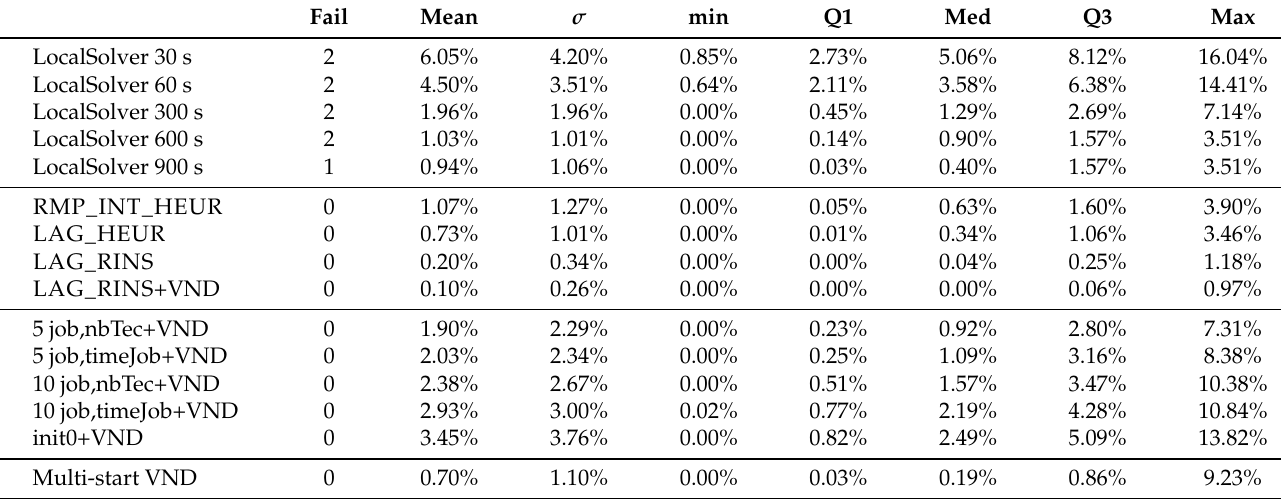
Table 5. Comparison of the solution quality of local search approaches for the complete dataset. LocalSolver results are reported for defined time limits, CG heuristics and VND matheuristics at termination. For VND matheuristics, different initializations are provided, and the multi-start VND considers the reported initialization for a parallel or multi-start